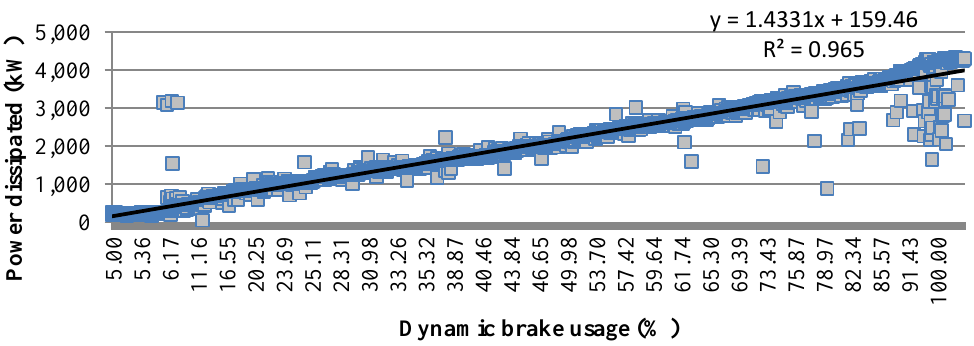
Figure 2. Relation between the use of a dynamic brake and the power dissipated.